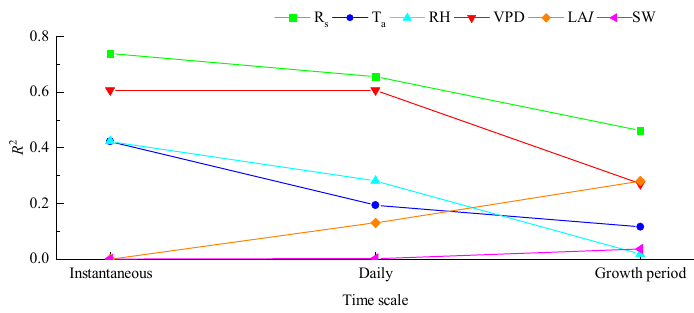
Figure 7. The determinants of each factor change with the increase of scale.